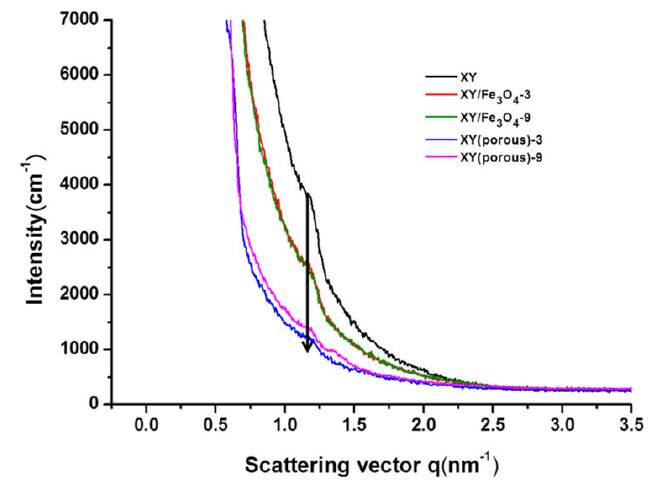
Figure 4. Small angle X-ray scattering (SAXS) patterns of the bare XY, composite, and porous membranes.